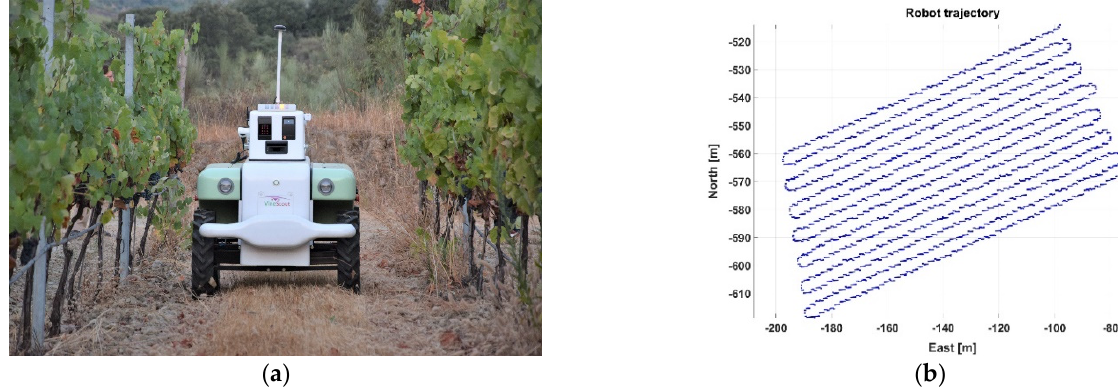
Figure 7. Acquisition of massive data from a vineyard: ( a ) autonomous robot for map generation in season 2020; and ( b ) trajectory traced by the monitoring robot in Map C (Table 1). Table 1. Mapping sessions providing data for a use case on harvesting zoning in